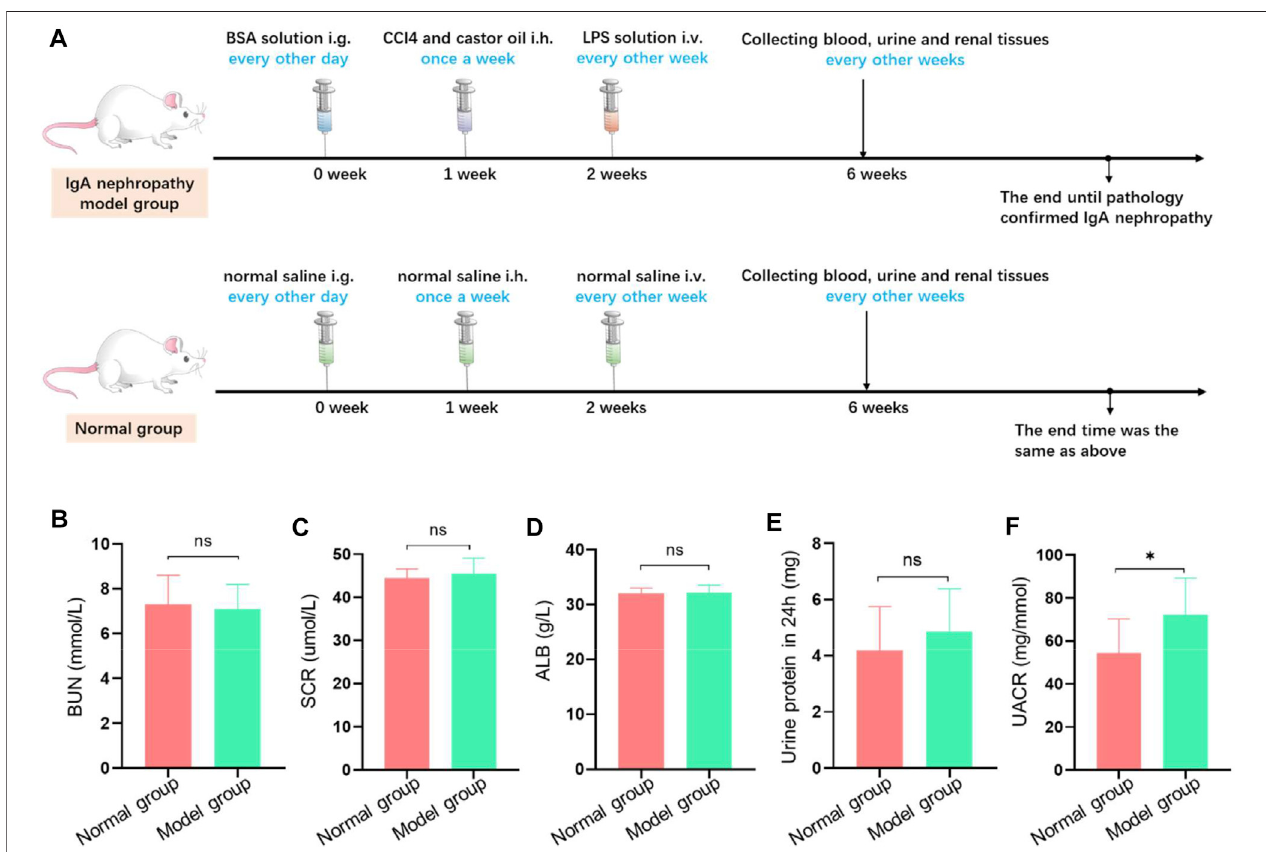
FIGURE 2 | Th e establishment of IgA nephropathy rat. (A) The scheme of dosing process to establish IgA nephropathy rat. (B – F) Biochemical test examination of rats with different treatment groups. There was no signi fi cant difference in blood bun (B) , blood Cr (C) , blood ALB (D) , and total 24-h urinary protein (E) between the model group and the normal group. Meanwhile, there was signi fi cant difference in the ratio of urinary albumin to creatinine concentration (F) between the model group and the normal group (* p < 0.05).